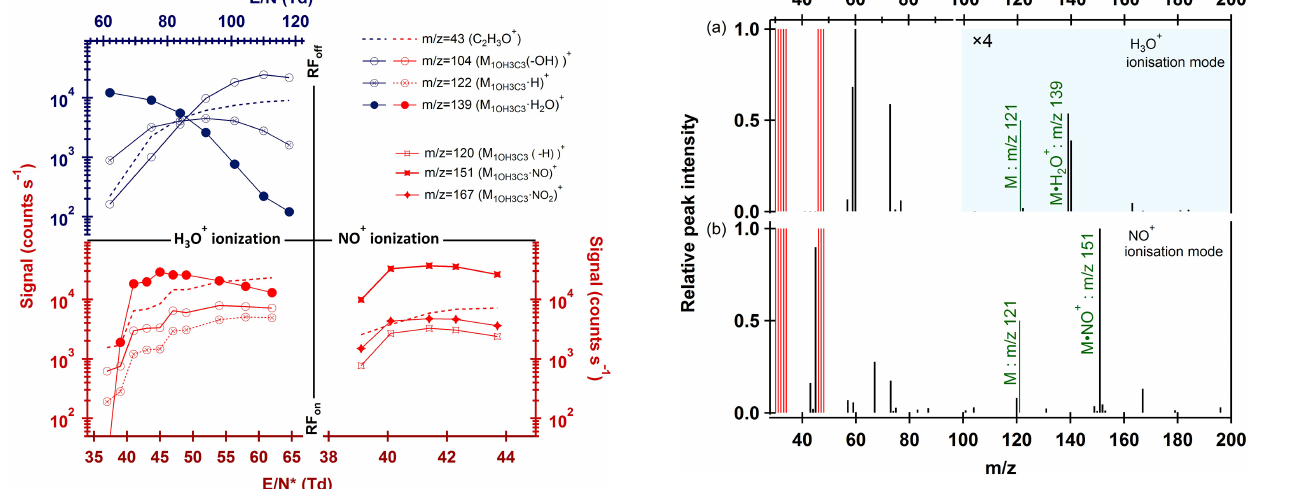
Figure 4. The E/N ratio influence over the 1OH3C3 identification for several representative signals in both ionization modes (H 3 O + , left; NO + , right) as recorded in absence (up) / presence (down) of a RF funnel. The common signal at m/z = 43 is equally plotted as a fragmentation mark (right axis).